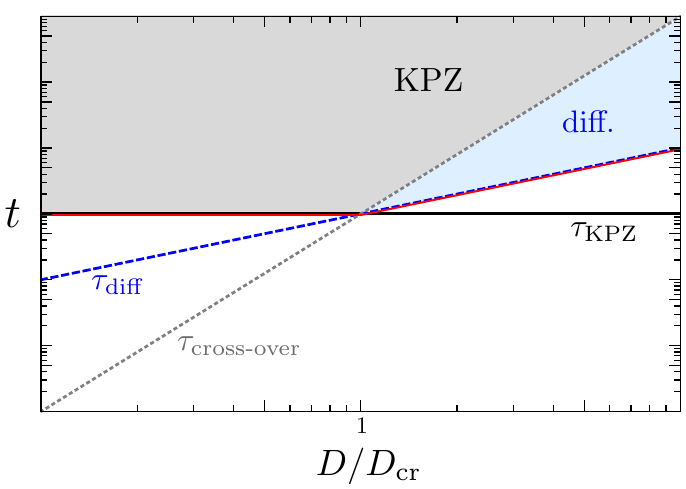
Figure 2: Hydrodynamic timescales as a function of the diffusion constant D , for T (cid:29) Λ . For D (cid:174) D , hydrodynamics is governed by KPZ (gray region), with the cr equilibration time bounded by τ (black line). For D (cid:166) D , the equilibration KPZ bound cr time satisfies a stronger diffusive bound τ (blue dashed line); hydrodynam- diff. bound ics is initially governed by diffusion (blue region) before transitioning to KPZ at τ (gray dotted line). The equilibration time therefore satisfies the bound cross-over τ (cid:166) max ( τ ) (red , τ eq KPZ bound diff. bound